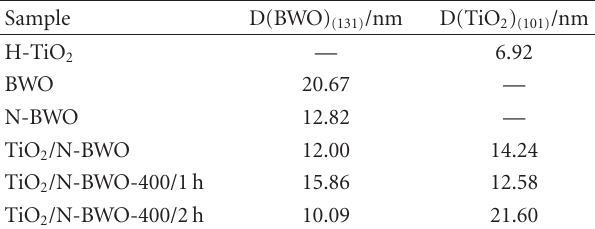
Table 1: Crystal sizes of the as-synthesized samples. Sample